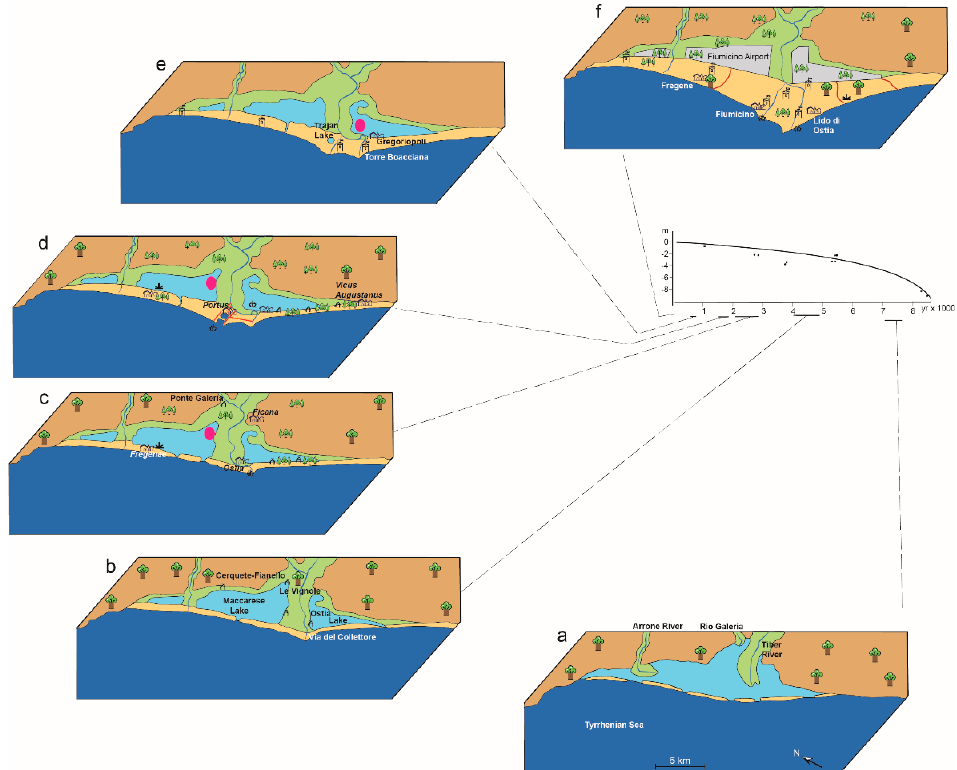
Figure 8. ( a – f ) . Two-dimensional evolutionary patterns of the Tiber delta area inferred from under- ground and historical/archaeological data. The individual images illustrate the coastal landscape relating to the period shown on the abscissa of the sea level rise curve. The Tiber delta was an area locally subject to repeated changes (excavation of canals and ports and abandonment of meanders) so as to make it difficult to trace a single sea level rise curve [81]. It was, therefore, decided to draw the curve based on only 14 C datings coming from the peat levels of Maccarese Lake. However, those of the Ostia Lake, which are positioned below the traced curve, are also shown in red on the graph.